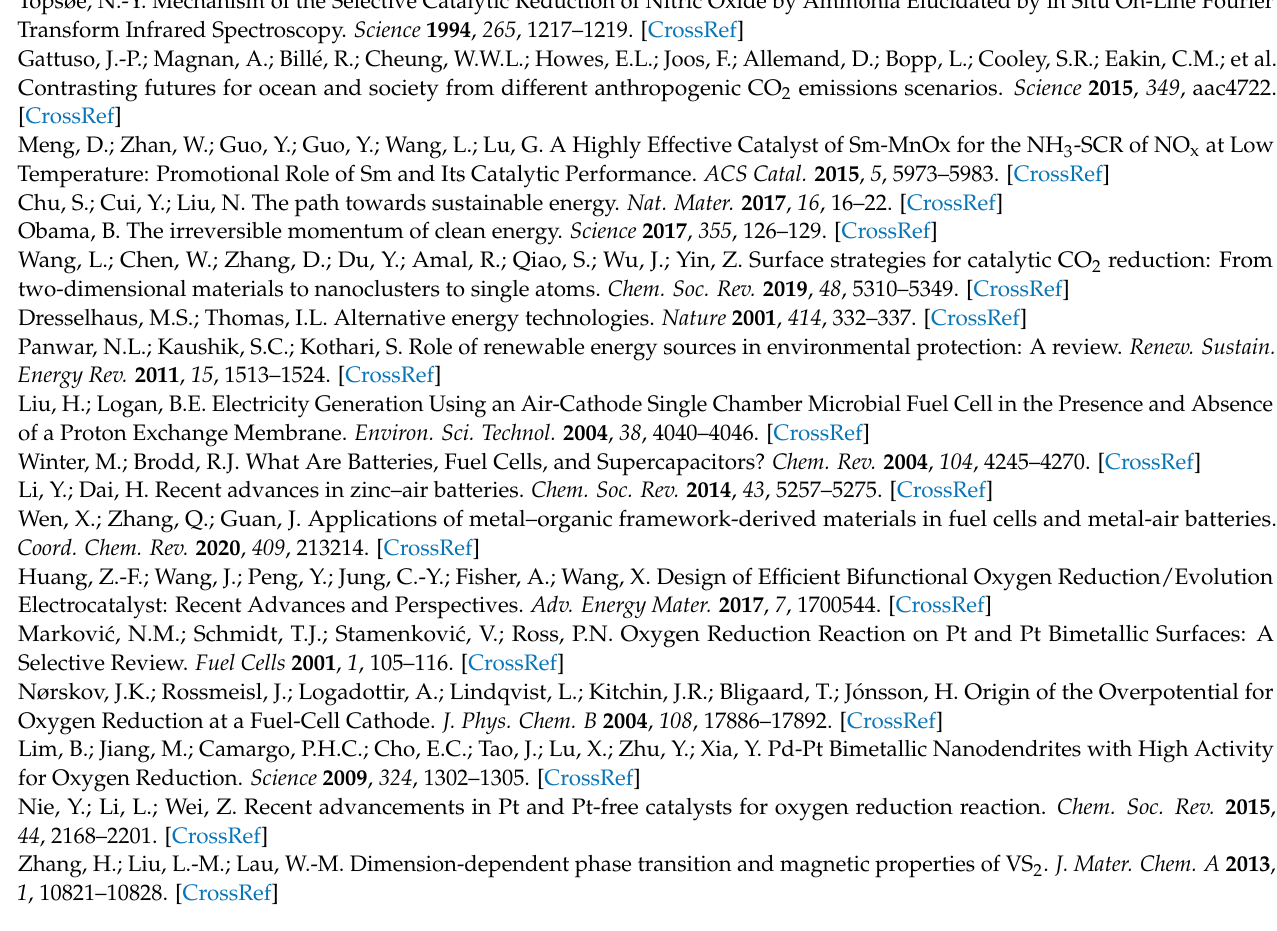
Tables S1: The computed the overpotentials ( η ORR , V) at various energy cutoff (eV) or k-points; Tables S2: The computed the overpotential ( η ORR ) and the free adsorption energies ( ∆ G, eV) for various X@CrS2